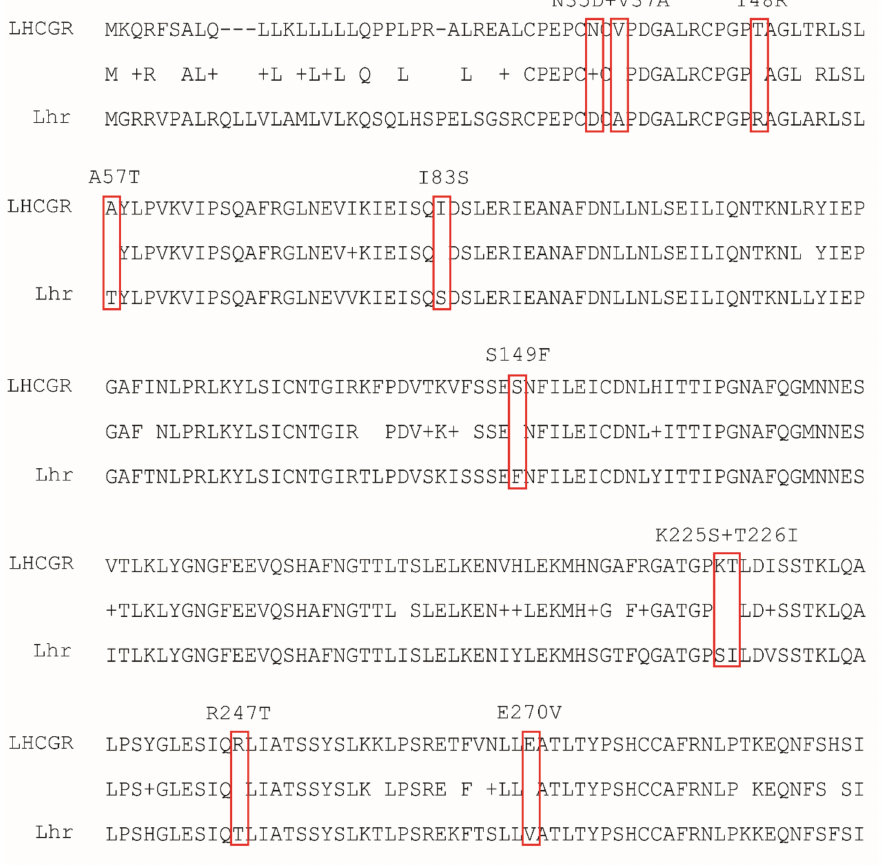
Figure 5. Alignment of LHCGR and Lhr aminoacidic extracellular domain sequences (1–300 aa), using the single-letter code for each amino acid. LHCGR amino acids in positions 35 and 37, 48, 57, 83, 149, 225, and 226, 247, 270 were substituted by mutagenesis with the corresponding murine amino acid (red boxes), as these are residues possibly involved in LH-hCG recognition